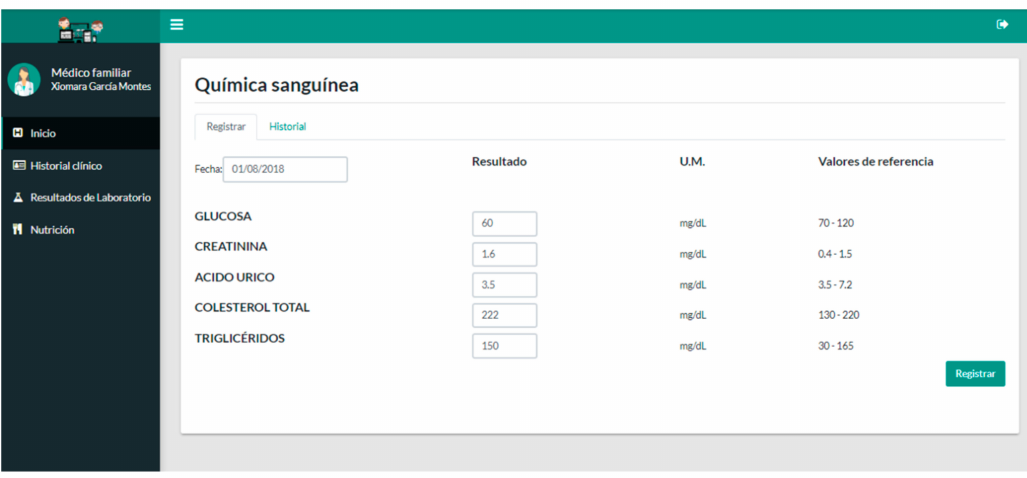
Figure 23. Physician application interface: The history of laboratory results of blood chemistry tests. The sub-modules of laboratory results have histories of each registered study (see Figure 24).